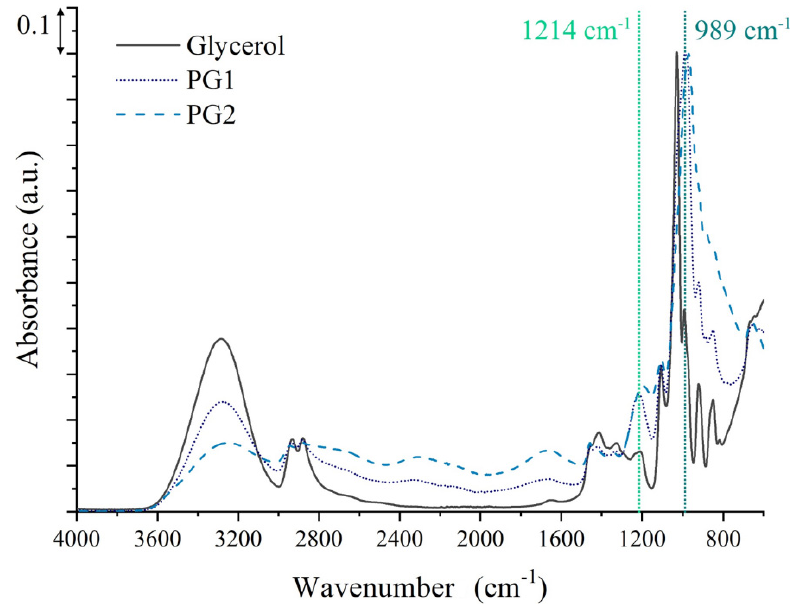
Figure 3. ATR-FTIR spectra of phosphorylated glycerol products PG1 and PG2 and pure glycerol as reference.